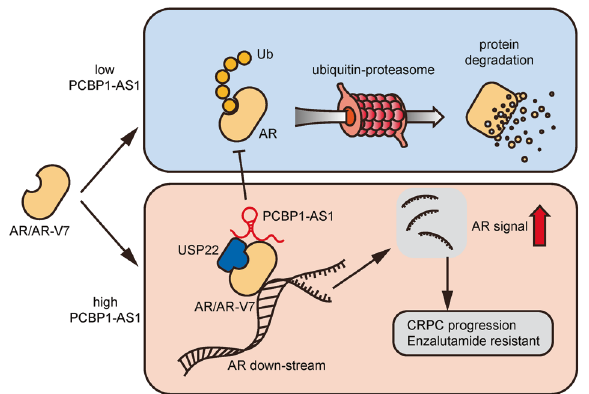
Fig. 6 PCBP1-AS1 promotes AR/AR-V7 deubiquitination and enzalutamide resistance by enhancing USP22-AR/AR-V7 complex stability. During CRPC, upregulated PCBP1-AS1 binds to USP22 and the NTD domain of AR/AR-V7, subsequently promotes AR/AR- V7 stability, represses AR ubiquitination, and promotes CRPC enzalutamide